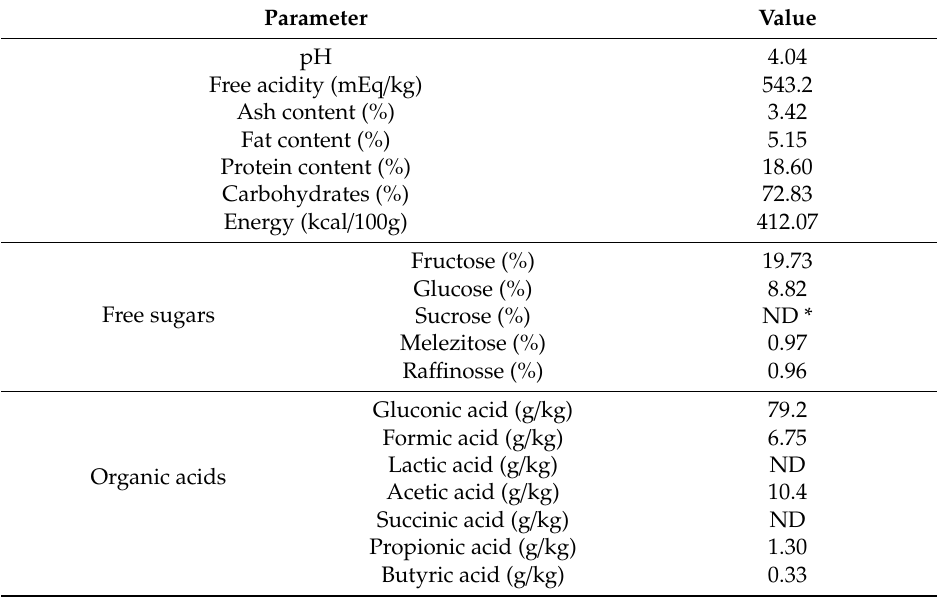
Table 2. Physicochemical parameters of bee